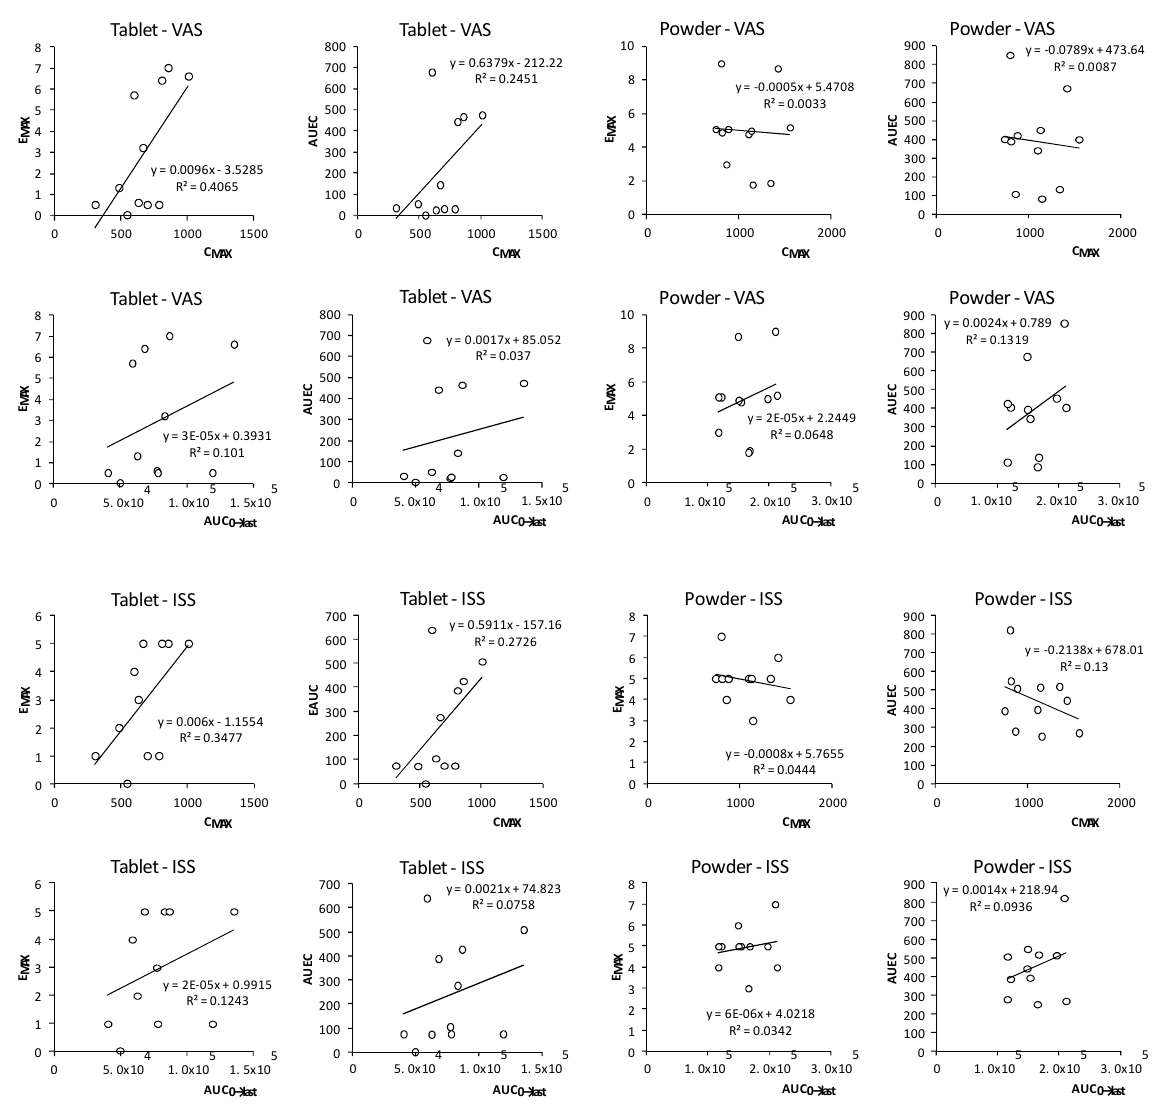
Figure 4. Correlation analysis between the pharmacokinetic parameters C MAX , AUC 0 → last and the pharmacodynamic parameters E MAX and AUEC obtained with the VAS and the ISS scale for the controlled-released powder blend and sustained-release tablet formulations.